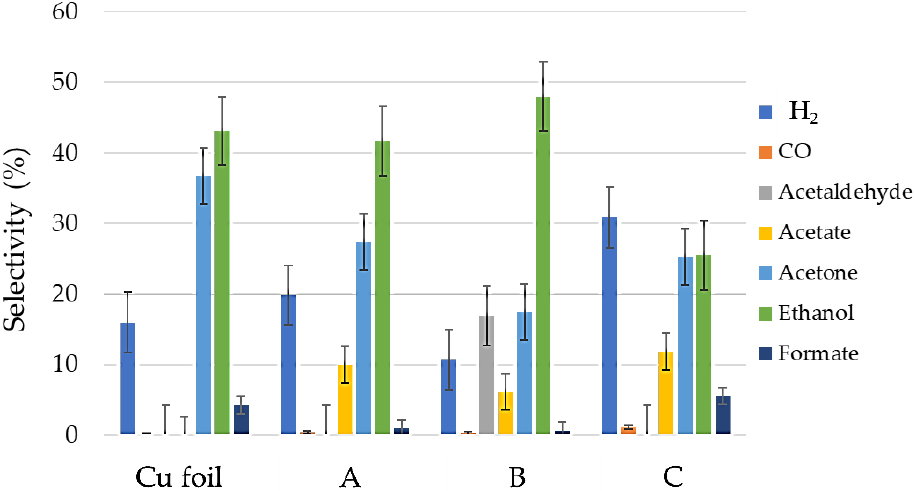
Figure 8. Selectivity of the chemical products of CO 2 RR obtained from different groups of Cu electrodes, Cu foil and the porous Cu electrodes from groups A, B, and C, electrodeposited with 3 A/cm 2 for 40 sec.